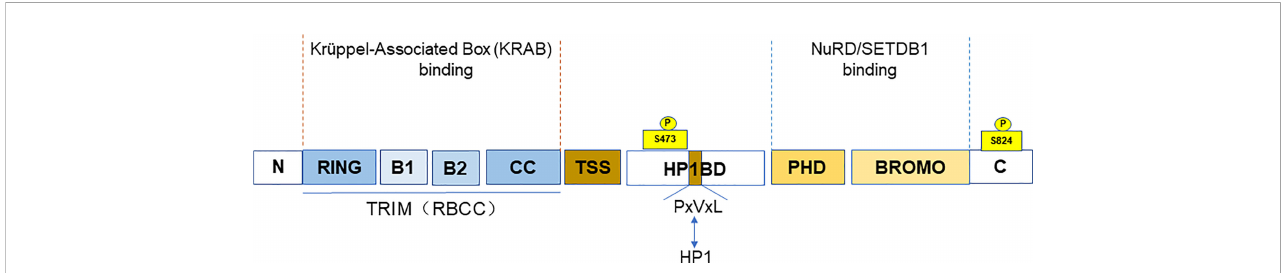
FIGURE 1 The domain and post-translational modi fi cations of TRIM28. The fi gure shows that the different domains of TRIM28. A TRIM structure, including a RING fi nger, two B-boxes, and a leucine zipper coiled-coil region (CC) at the N-terminus. The PxVxL pentapeptide region and the central TIF1 signature sequence (TSS) are at the central part. And the plant homeodomain (PHD) fi nger and the Bromodomain are at the C-terminus. The TRIM domain mainly binds to the KRAB domain of KRAB-ZNFs. While PHD fi nger and bromodomain recruit NuRD and SETDB. The fi gure also shows the TRIM28 phosphorylation sites (S473 and